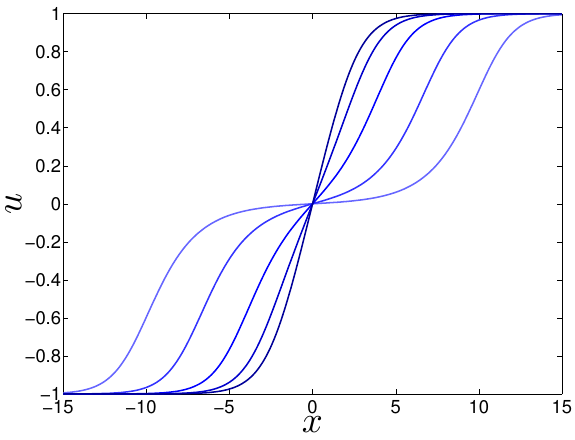
Figure 2 . The stationary solution, eq. (2.3), of our chosen φ 6 model, as ǫ is varied from 0 . 01 to 0 . 05 to 0 . 2 to 0 . 5 and to 1 (lighter color curves to darker color curves, respectively). Clearly, this solution is of the form of two kinks bound